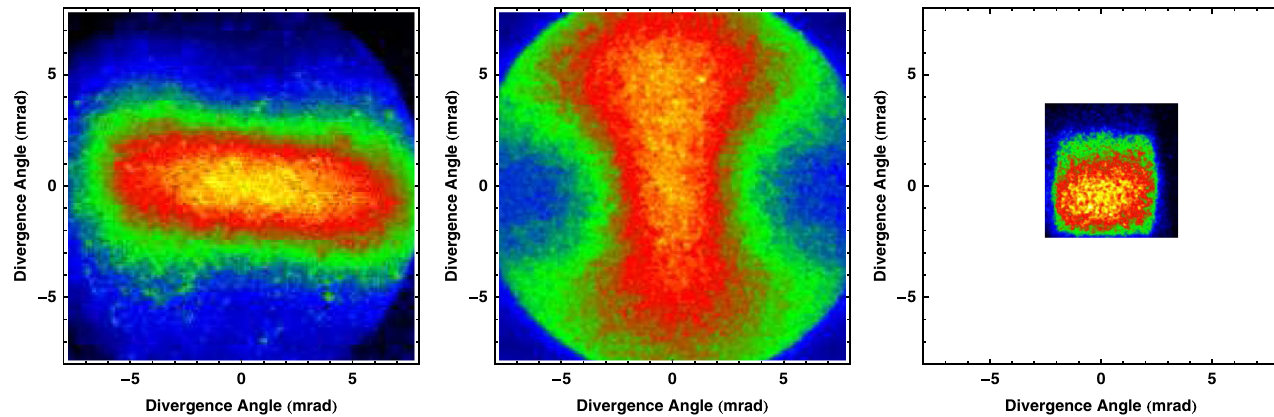
FIG. 10. (Color) (cid:1) -ray beam profiles from scintillator-coupled CCD cameras for the three laser frequencies. The beam energies are: left—295 keV ( 128 : 4 MeV þ 1 ! ), center—466 keV ( 114 MeV þ 2 ! ), and right—906 keV ( 130 MeV þ 3 ! ).